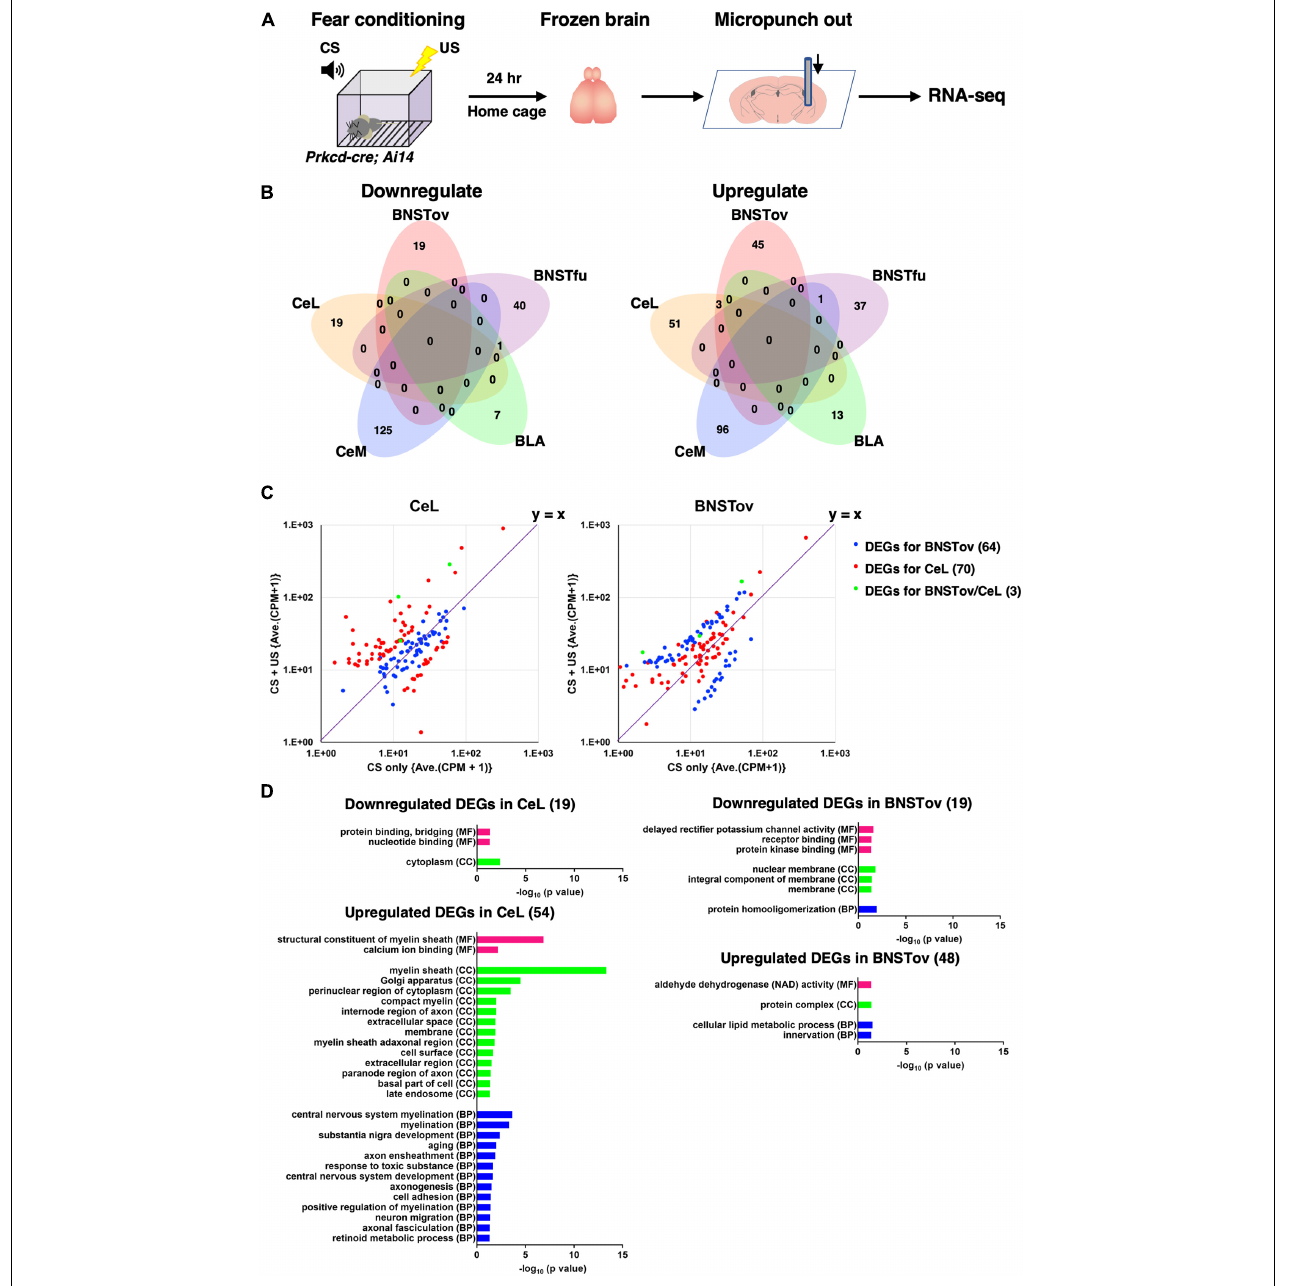
FIGURE 5 | Gene expression changes after fear conditioning. (A) Schematic diagram of tissue collection and RNA-seq from mice after fear conditioning. (B) Venn diagrams showing the overlap of DEGs in CS-only (control) vs. CS–US (DEGs fearconditioning ) between five amygdala subnuclei. (C) Scatterplots representing the FCs of averaged CPM between CS-only vs. CS–US of DEGs fearconditioning for the BNSTov (blue), the CeL (red), and both (green). The values in parentheses indicate the number of DEGs. (D) GO analysis for the downregulated or upregulated DEGs fearconditioning of the BNSTov or the CeL using DAVID Bioinformatics Resources ver. 6.8. Significantly enriched GO terms ( p < 0.05) in molecular function (MF), cellular component (CC), and biological process (BP) were presented. The values in parentheses indicate the number of DEGs.